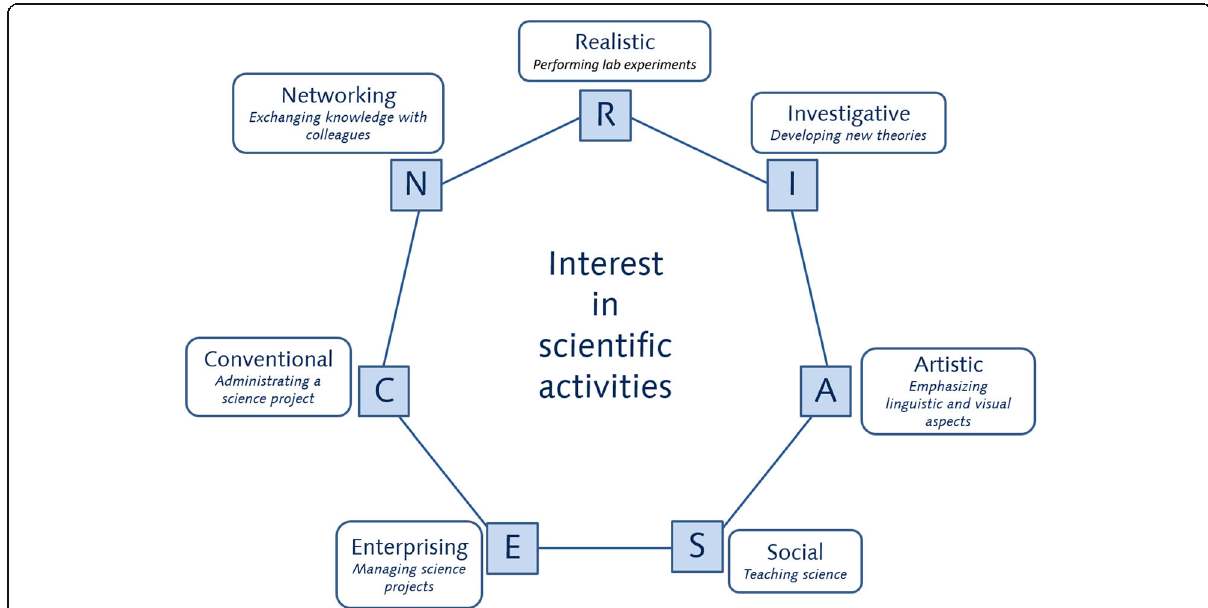
Fig. 1. RIASEC+N model. Interest in scientific activities according to the adapted RIASEC+N